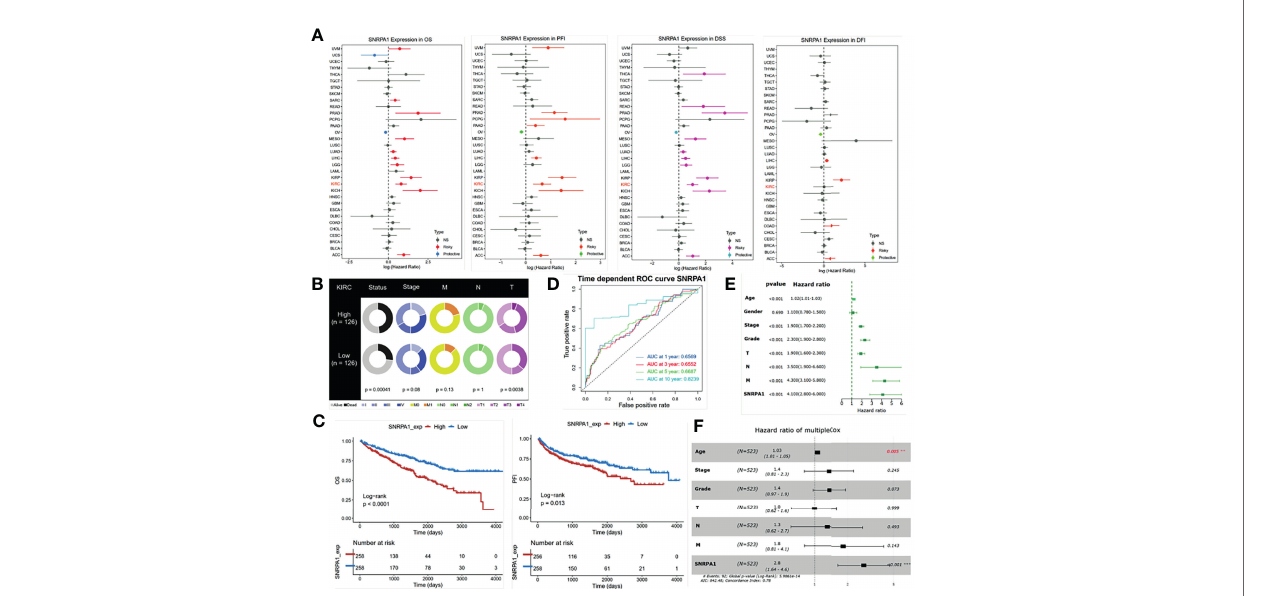
FIGURE 3 | Prognostic value of SNRPA1 in ccRCC. (A) Relationship between SNRPA1 expression level and prognosis (from left to right is OS, PFI, DSS, and DFI) of pan-cancer from the TCGA database. (B) Different distribution of clinical features of ccRCC patients with high expression and low expression of SNRPA1. (C) Survival curves of OS and PFI in ccRCC patients from the TCGA database. (D) Time-dependent ROC curve of OS based on SNRPA1 expression. (E, F) Univariate and multivariate Cox regression of SNRPA1 expression and other clinical